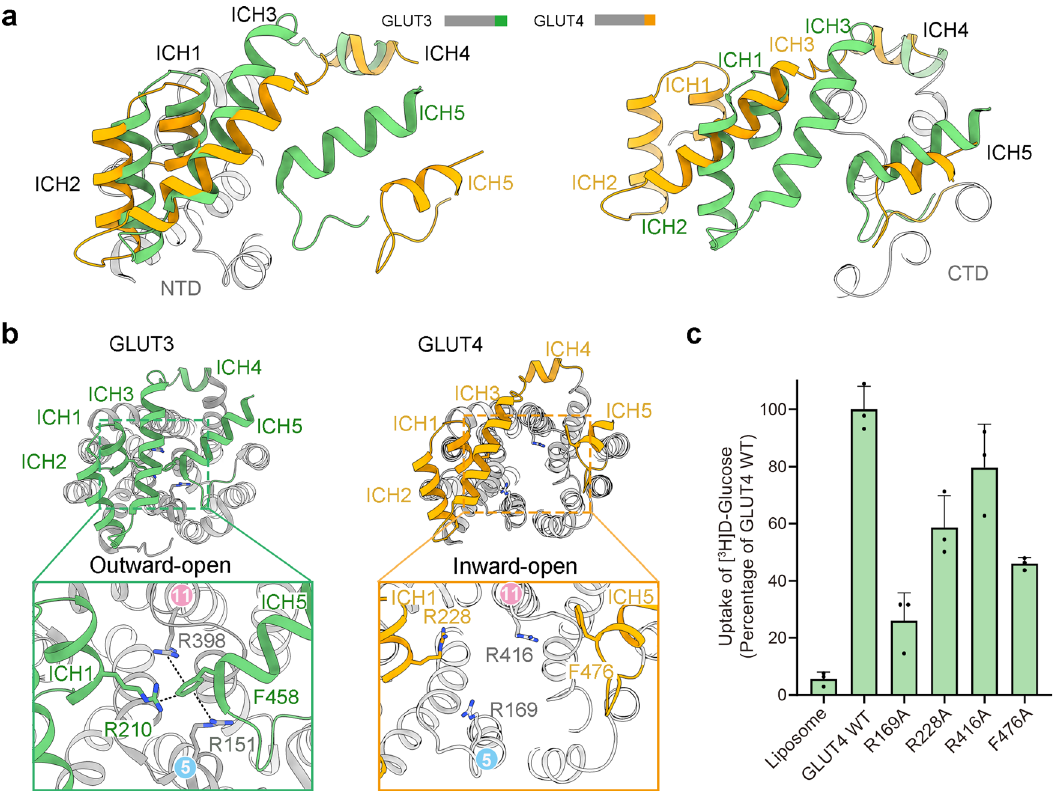
Fig. 4 The ICH domain contributes to the intracellular gating during alternating access cycle of GLUTs. a Conformational changes of the ICH domain between the outward-occluded GLUT3 and inward-open GLUT4 structures. The cryo-EM structure of GLUT4 is superimposed to the crystal structure of GLUT3 (PDB code: 4ZW9) relative to the N (left) and C (right) domains, respectively. b A conserved Phe residue on ICH5 serves as a local organizing center in the outward-facing state. left, Phe458 on helix ICH5 forms cation- π interactions with multiple Arg residues in the N and C domains of outward- facing GLUT3. right, Rearrangement of the ICH domain in inward-open GLUT4. Phe476 in GLUT4 (equivalent of Phe458 in GLUT3) no longer interacts with any of the Arg residues in the inward-open state. c The interaction between Phe458 and N-domain Arg residues contributes to the transport activity of GLUTs. Shown here are normalized transport activities of GLUT4 variants in the liposome-based counter fl ow assay. Data are presented as mean with standard deviation, in three independent experiments. Source data are provided as a Source Data fi le.